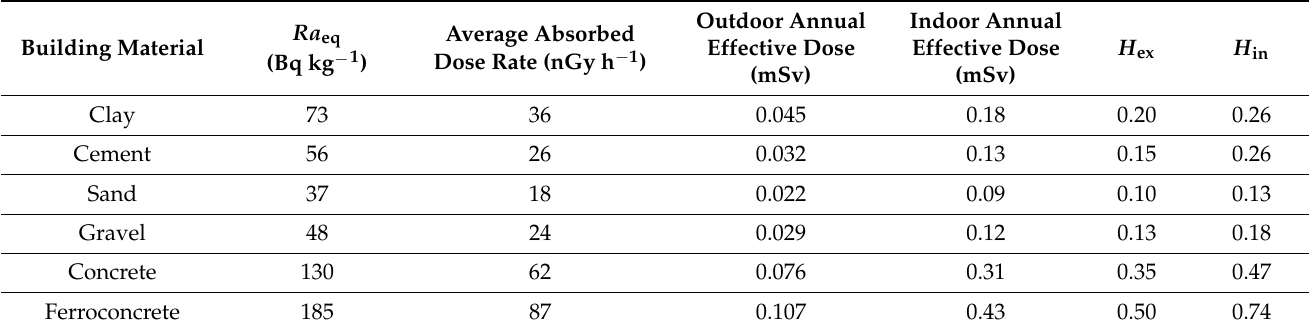
Table 3. The average values of absorbed dose rate, annual effective dose, and hazard parameters for building materials.